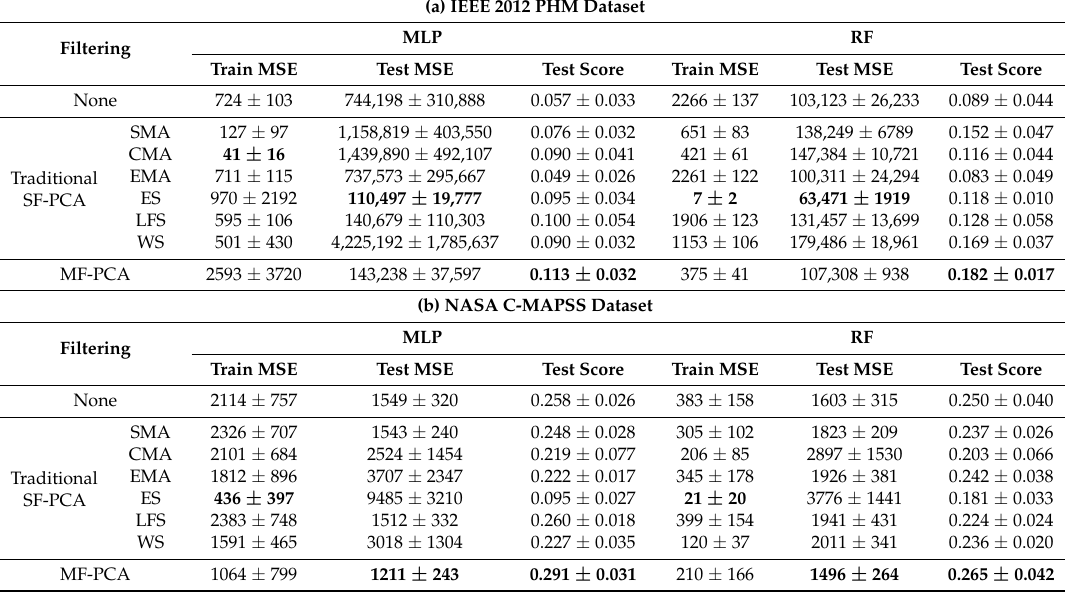
Table 3. Performance comparisons of MF-PCA and SF-PCA approaches. ( a ) IEEE 2012 PHM